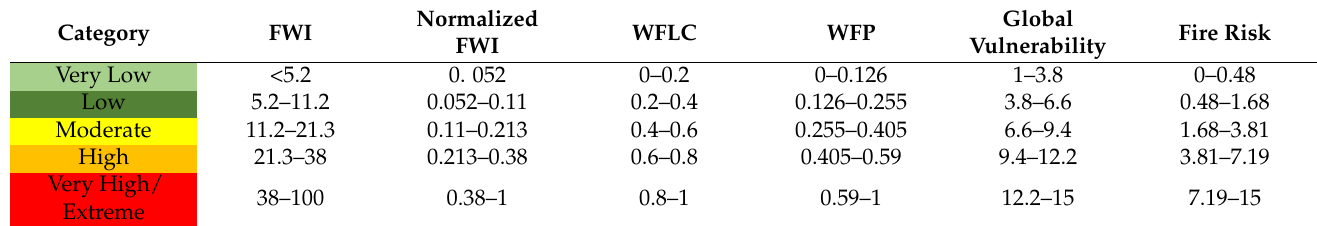
Table 2. Fire sensitivity classification for each index for risk